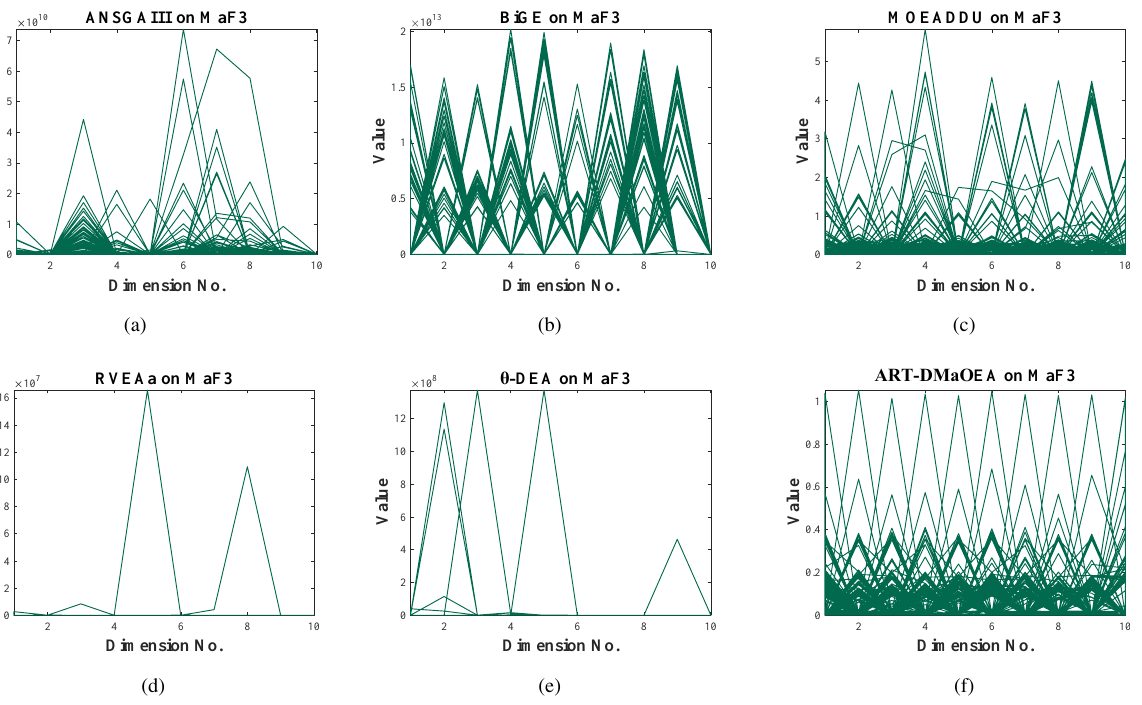
Figure 7. The best populations obtained by the six algorithms on ten-objective MaF3, as shown by Fig. 7: The final populations obtained by the six algorithms on 10-objective MaF1, shown by parallel coordinates. parallel